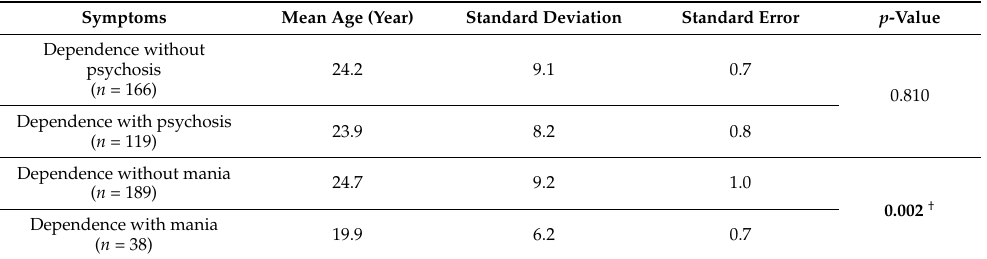
Table 6. The age METH users developed METH-induced psychosis and mania.